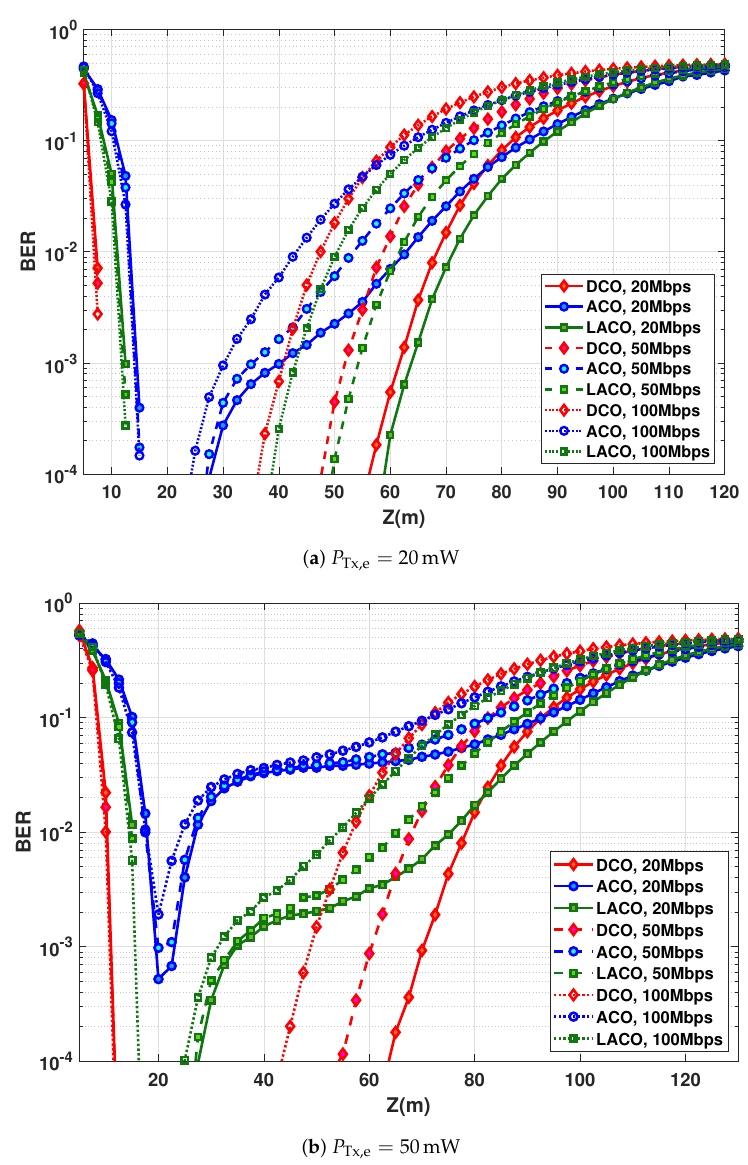
Figure 10. BER performance as a function of distance for DCO, ACO and LACO-OFDM. Spectral efficiency of ∼ 2bps/Hz using, e.g., 16QAM for DCO. N = 1024, N CP = 5, 11, and 20, for R b = 20, 50, and 100Mbps, respectively. Electrical transmit power of ( a )20mW and ( b